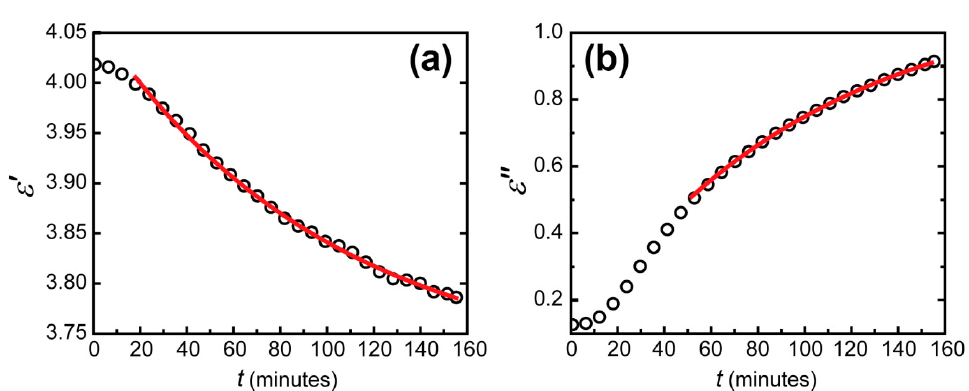
Figure 5. Dependence of the imaginary ( a ) and real ( b ) parts of the dielectric permittivity of tungsten trioxide on time (black circles) for an excitation wavelength of 705 nm and the exponential fit of this dependence on time (red lines).